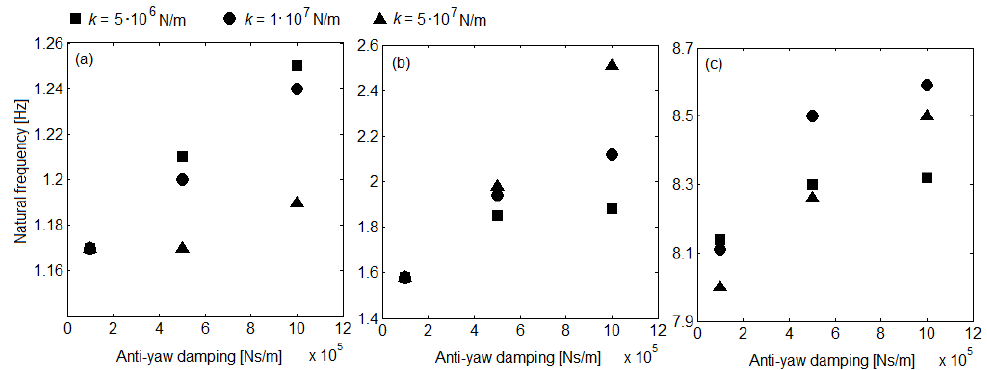
Figure 6. Influence of the damping and the anti-yaw damper stiffness upon the carbody eigenfrequencies: ( a ) bounce eigenfrequency; ( b ) pitch eigenfrequency; ( c ) bending eigenfrequency.